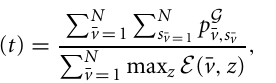
1; on the contrary, the quantity of energy that bacterium 1 is available to transfer to bacterium 23 is much lower. Nonethelss, the two bacteria will be able to establish an effective connection, although with different intensities, because the corresponding state variables x 1 , 23 and x 23 , 1 lie above threshold η . The stars correspond to effective connections and energy